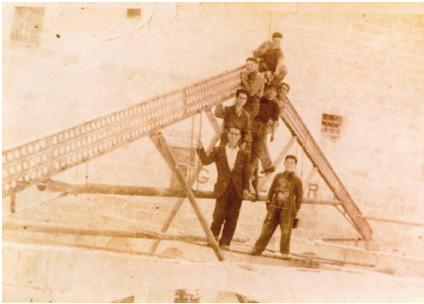
Figure 5: Historical image of iron trusses.